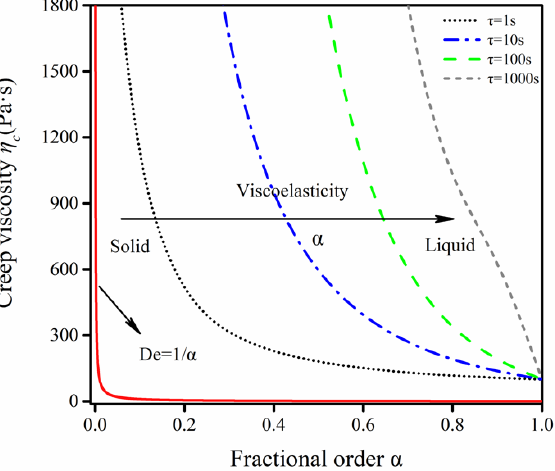
Figure A1. Variance of creep viscosity function over fractional order ranges from zero to one.